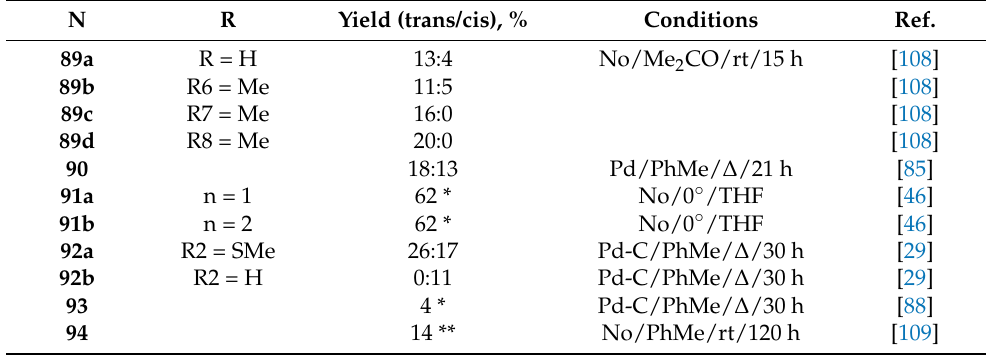
* Not determined, ** In a